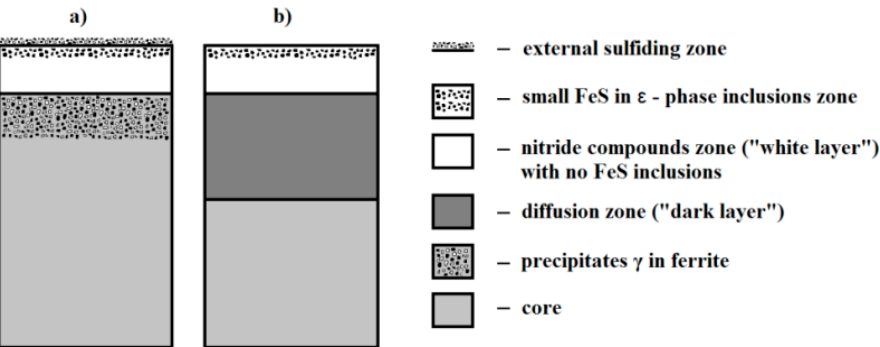
Figure 1. Scheme of surface layer (SL) structure on the parts after gas sulfonitriding for: ( a ) Carbon steel and grey plain cast iron; ( b ) alloy steel and alloy cast iron (based on [17]).